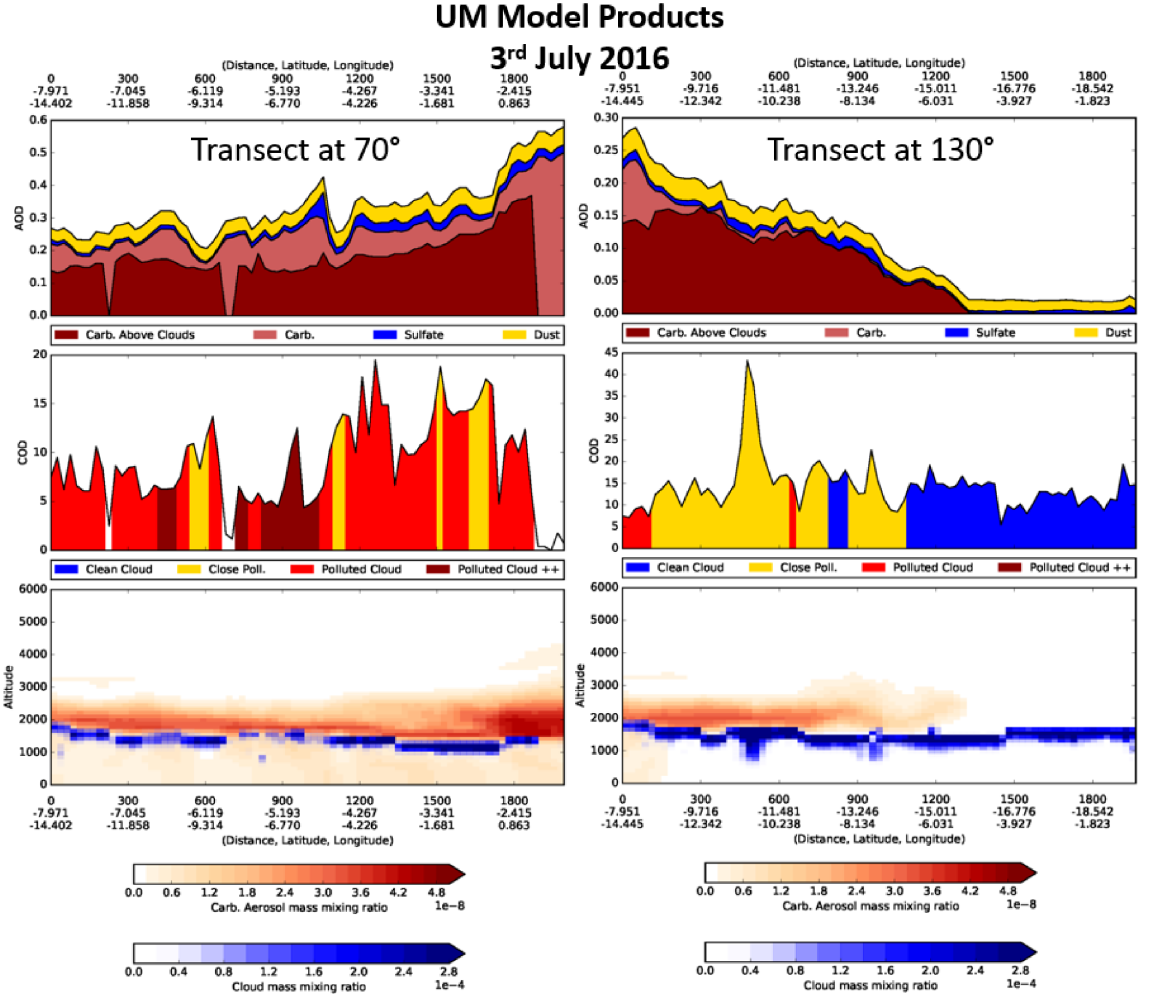
Figure 5. Model products derived at the 70 ◦ transect (column 1) and 130 ◦ transect (column 2) shown in Fig. 4. Aerosol optical depth (AOD) at 550nm is split into the three component aerosol types within the CLUMP model, and the carbonaceous (carb) aerosols that include BBA are further subdivided into above-cloud and below-cloud components. Cloud optical depth (COD) is subdivided into (i) “clean” (aerosol concentrations < 3µgkg − 1 ), (ii) clean but close to pollution (aerosol concentrations < 3µgkg − 1 but within 200m in the verti- cal of aerosol ≥ 3µgkg − 1 ), (iii) polluted (aerosol concentrations ≥ 3µgkg − 1 ), and (iv) very polluted (aerosol concentrations ≥ 10µgkg − 1 ). The third row shows the vertical profile of carbonaceous aerosols (red) and cloud (blue) mass mixing